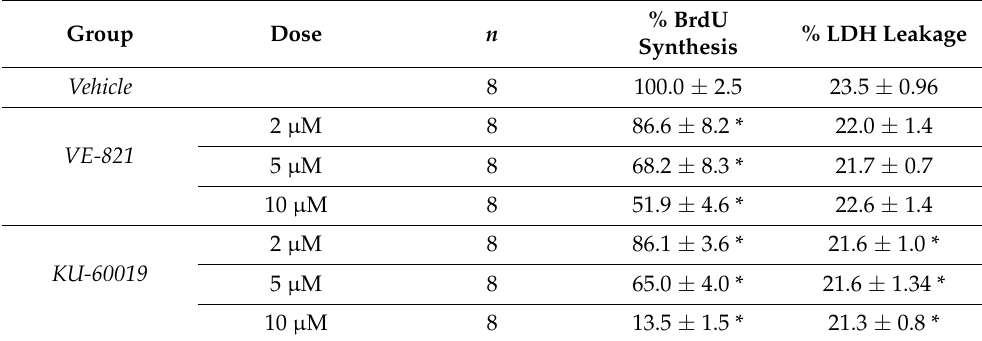
Table 1. Effect of VE-821 and KU-60019 on bromodeoxyuridine (BrdU) synthesis and lactate